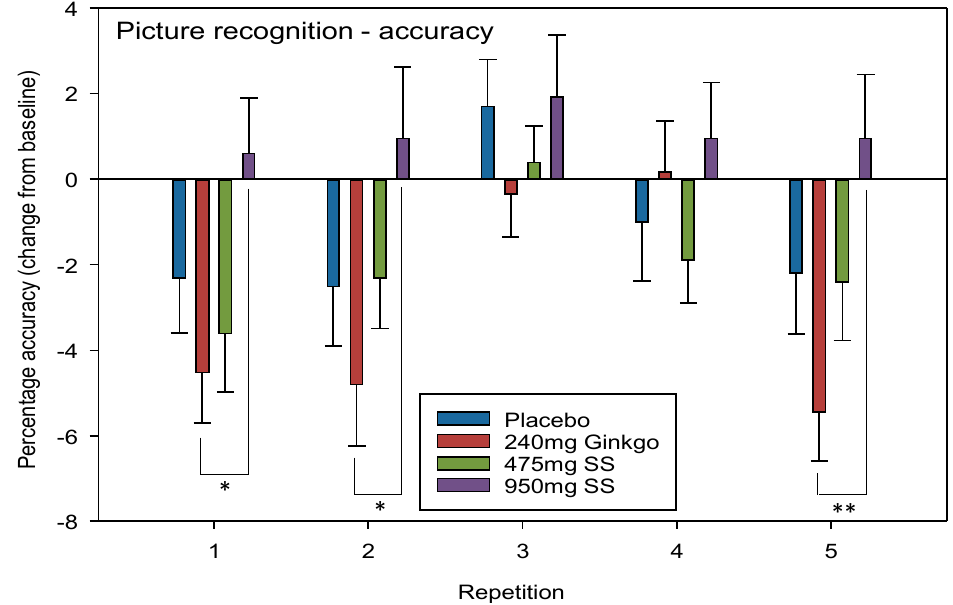
Figure 4. Picture recognition accuracy. Mean (±SEM) change ‐ from ‐ baseline scores on picture recognition accuracy (percentage correct) on Day 1 (repetition 1 = post ‐ dose repetition 1 on Day 1,